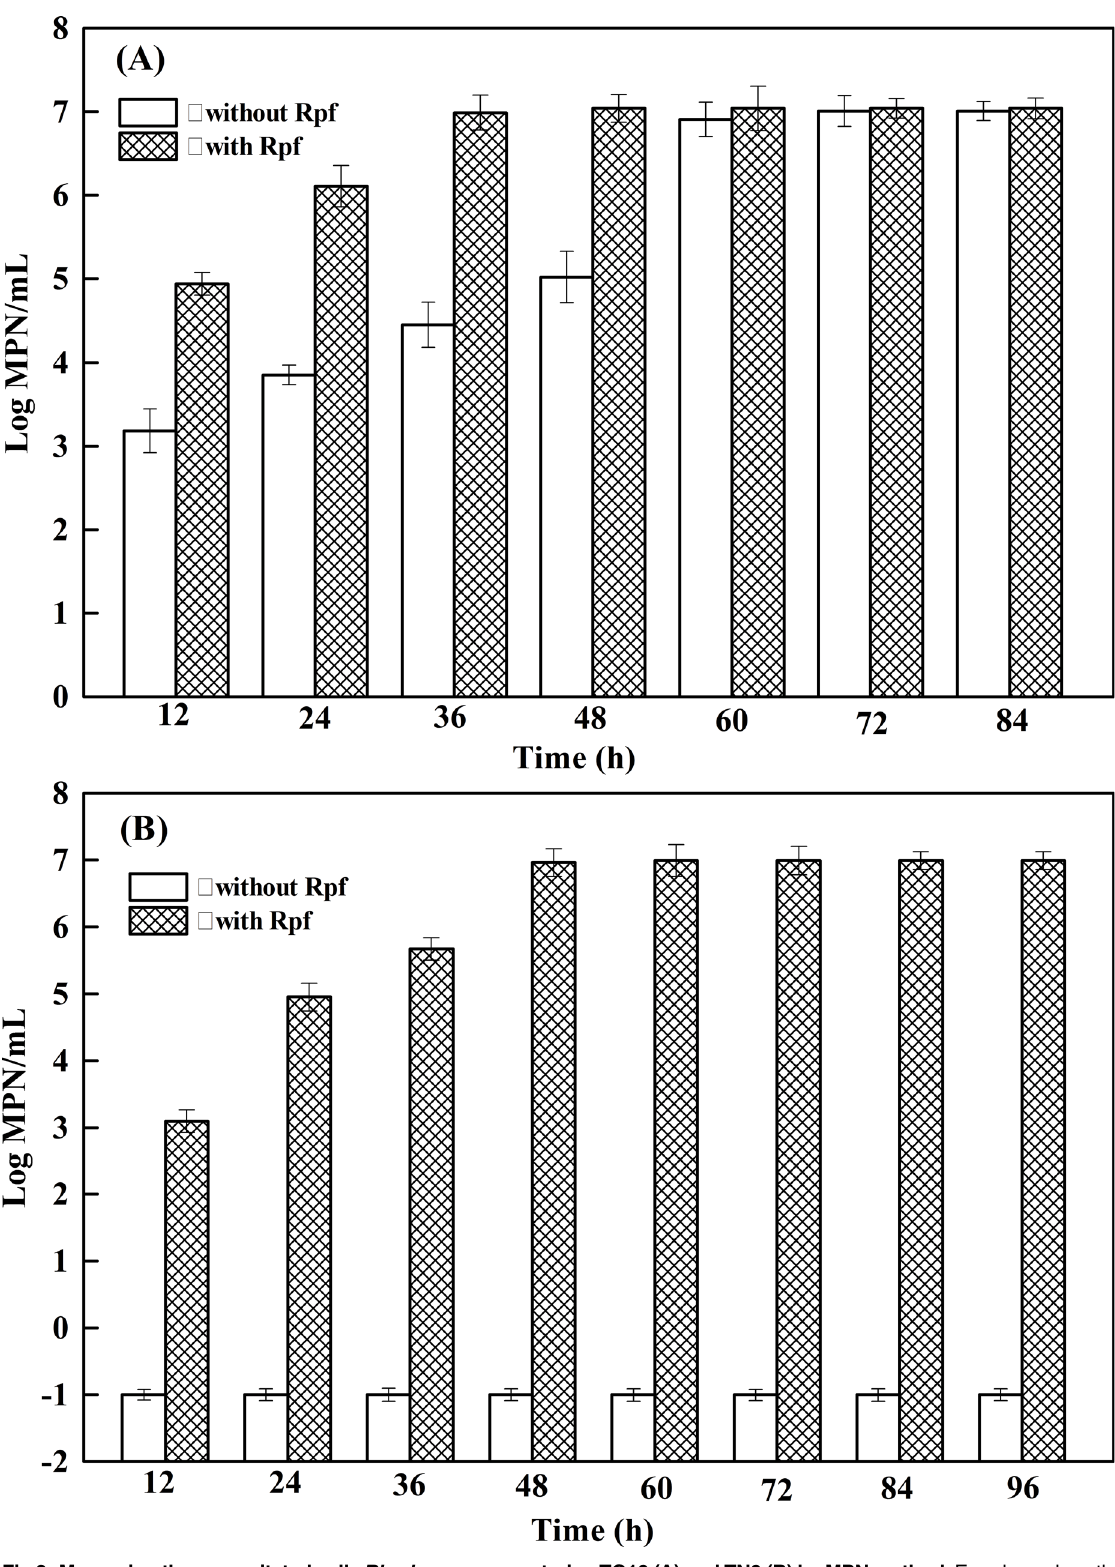
Fig 2. Measuring the resuscitated cells Rhodococcus sp. strains TG13 (A) and TN3 (B) by MPN method. Error bars show the standard deviations of triplicate experiments. doi:10.1371/journal.pone.0147593.g002 PLOS ONE | DOI:10.1371/journal.pone.0147593 January 25,